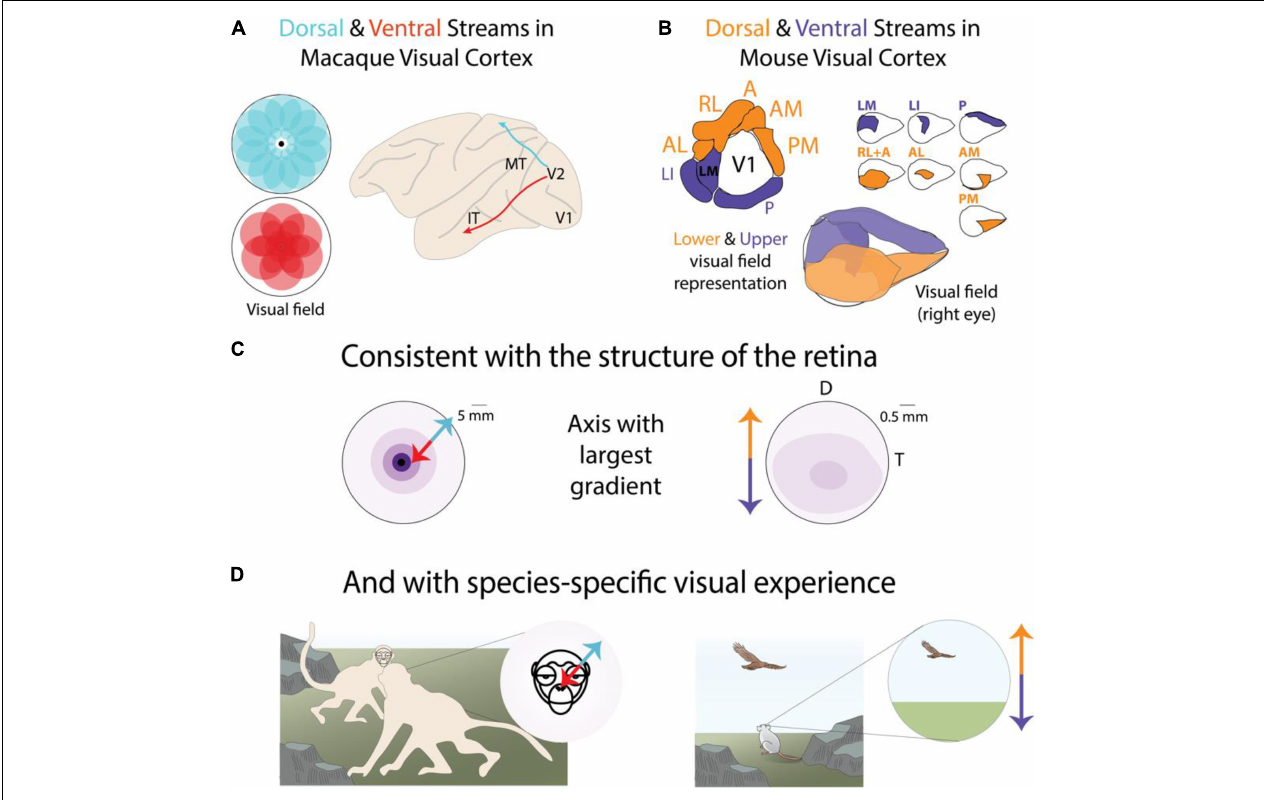
FIGURE 5 | Parallel stream organization reveals species-specific joint encoding of location and features across the entire visual system. (A) The macaque functional parallel streams exhibit distinct biases along the central-peripheral axis of the visual field (Yu et al., 2015; Shetht and Young, 2016). (B) The mouse functional parallel streams exhibit distinct biases along the elevation axis of the visual field (Garrett et al., 2014; Zhuang et al., 2017). (C) Topographical distribution of RGCs in the macaque and mouse retina exhibit their largest variance along different axes (Heukamp et al., 2020). Darker colors indicate higher density. (D) The visual behaviors of macaques and mice are broadly consistent with distinct functional relevance of central-peripheral or upper-lower visual fields. Panel modified with permission from © 2021 Dina